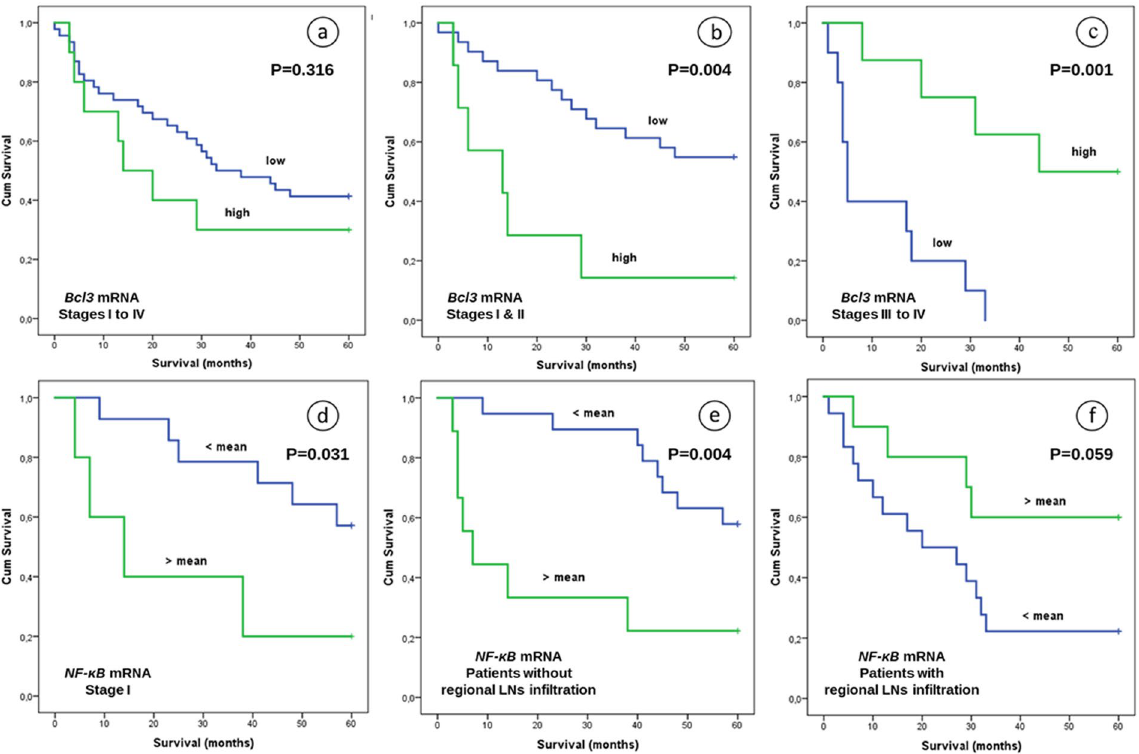
Figure 5. Overall survival of NSCLC patients after 5 years observation in relation to: ( a ) Bcl3 mRNA expression in patients of stages I to IV (cut-off point 2.09), ( b ) Bcl3 mRNA expression in patients of stages I and II (cut-off point 2.09), ( c ) Bcl3 mRNA expression in stages III & IV (cut-off point 0.43), ( d ) NF- κΒ 2 mRNA expression in stage I patients, ( e ) NF- κΒ 2 mRNA expression in patients without regional lymph node (LN) infiltration and ( f ) NF- κΒ 2 mRNA expression in patients with regional LN infiltration. P values refer to univariate